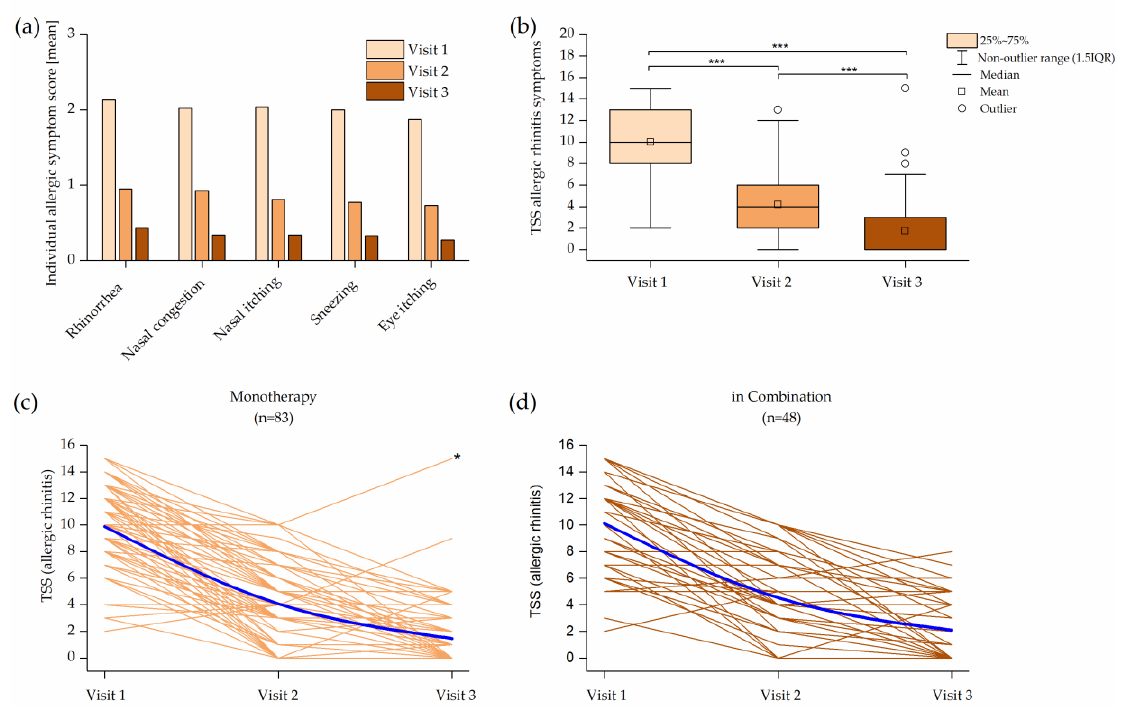
Figure 4. Effect of treatment over the treatment duration: ( a ) individual allergic symptoms for all symptom scores were mutually significant between the visits ( p < 0.001); ( b ) box plot of the allergic total symptom score (TSS) (*** = p < 0.001); ( c ) time course of the individual allergic TSS values for subjects with Ze 339 monotherapy. Patients receiving monotherapy showed a significantly lower symptom score ( p = 0.023) and lower effect variability ( p = 0.001) at the end of treatment compared to those receiving concomitant medication. ( d ) Time course of the individual allergic TSS for subjects with concomitant therapy. Blue lines indicate the mean of the TSS. * Patient suffered from chronic respiratory infection.